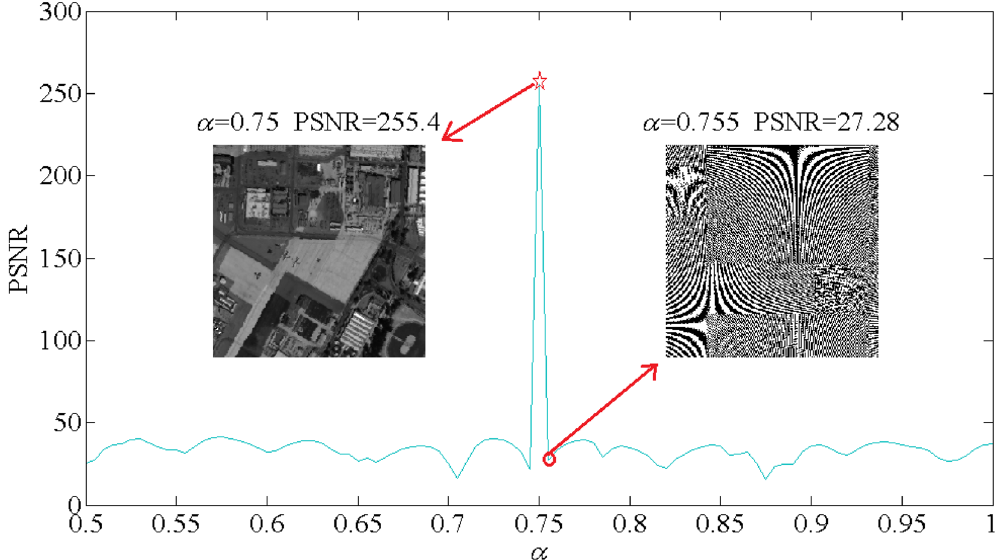
Figure 8. The PSNR curve between original image and attack result by using changing α